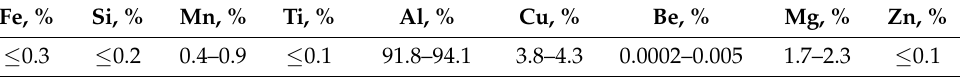
Table 2. Chemical composition of aluminum. Table 2. C hemical composition of aluminum.